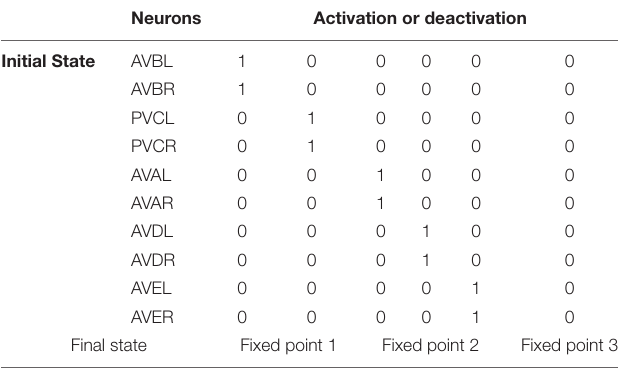
TABLE 2 | The state transition to different fixed points for activation of specific neuron pairs. Neurons Activation or